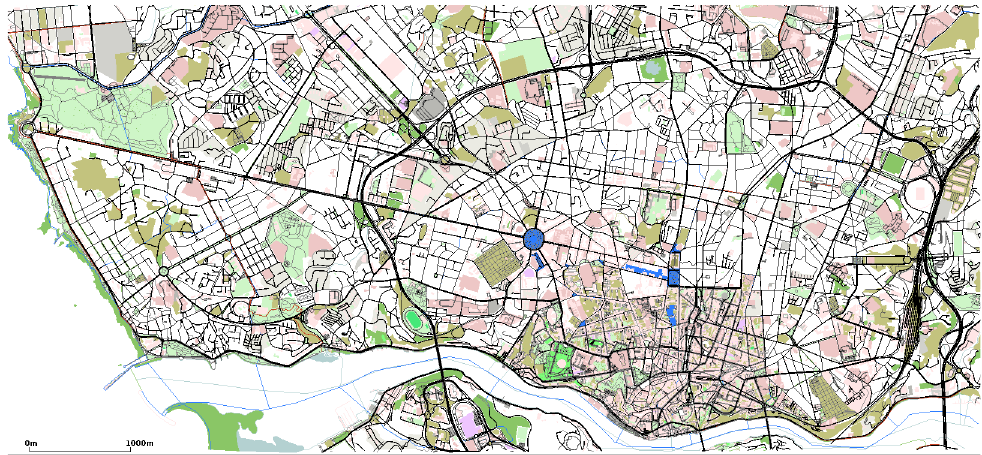
Figure 5. SUMO scenario of Porto map extracted using OSM.